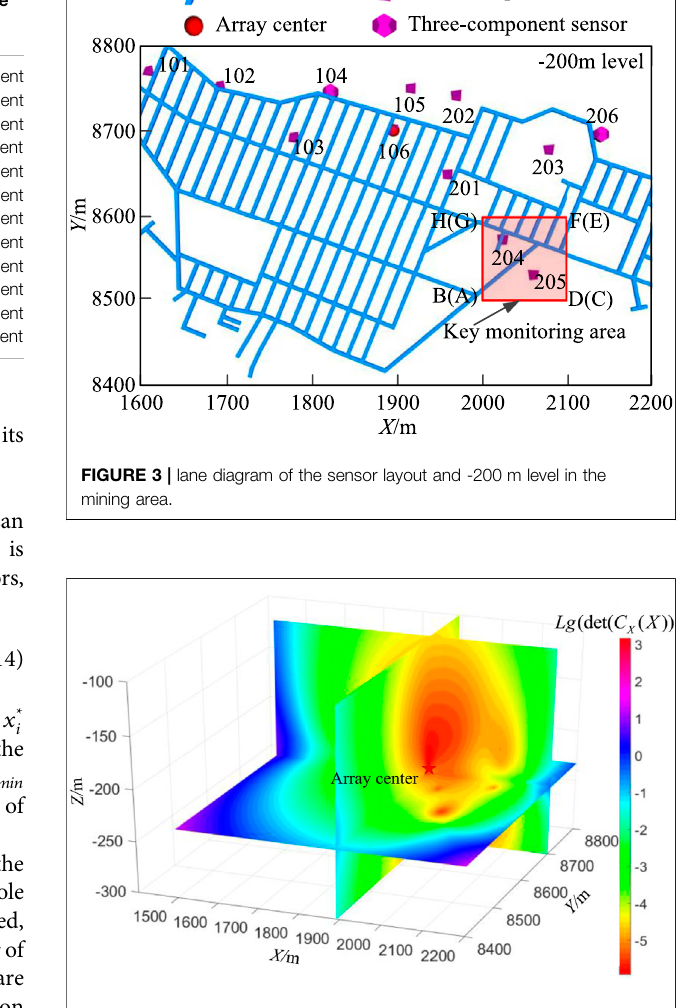
FIGURE 4 | Spatial distribution diagram of det [ C X ( X )]